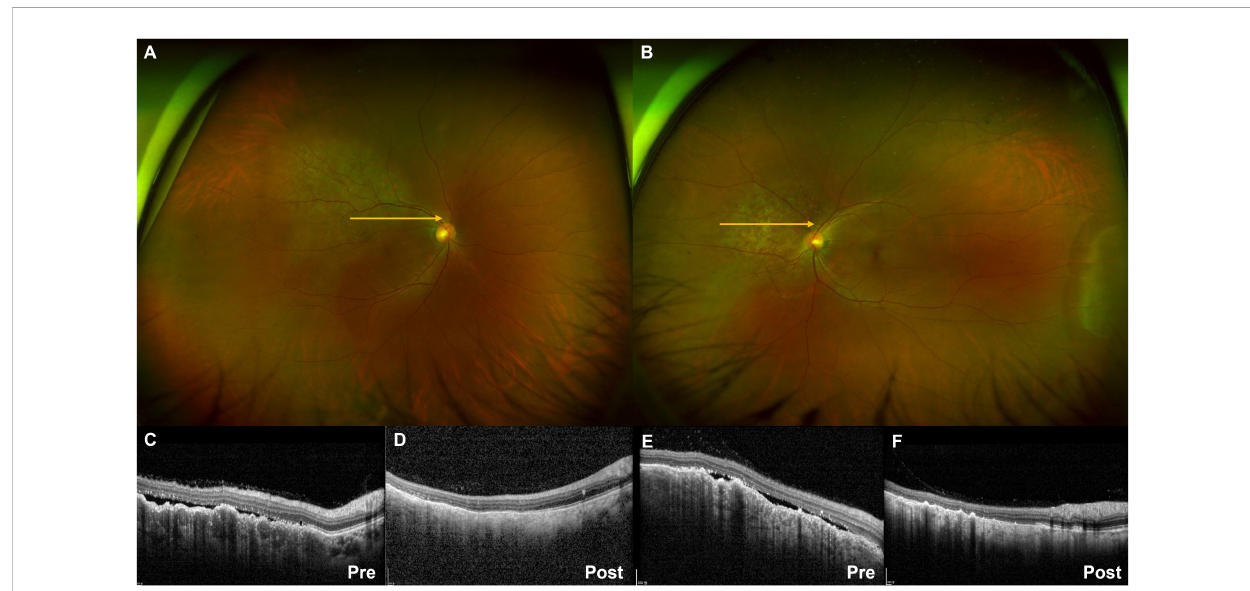
FIGURE 1 Ultra-wide fi eld fundus photography showing pigmented choroidal elevated lesions in the right (A) and left (B) eye. Yellow arrows indicate the optical coherence tomography (OCT) scan direction. The subretinal fl uid and choroidal folds on OCT images before treatment (C, E) showed improvement after selpercatinib treatment (D, F)